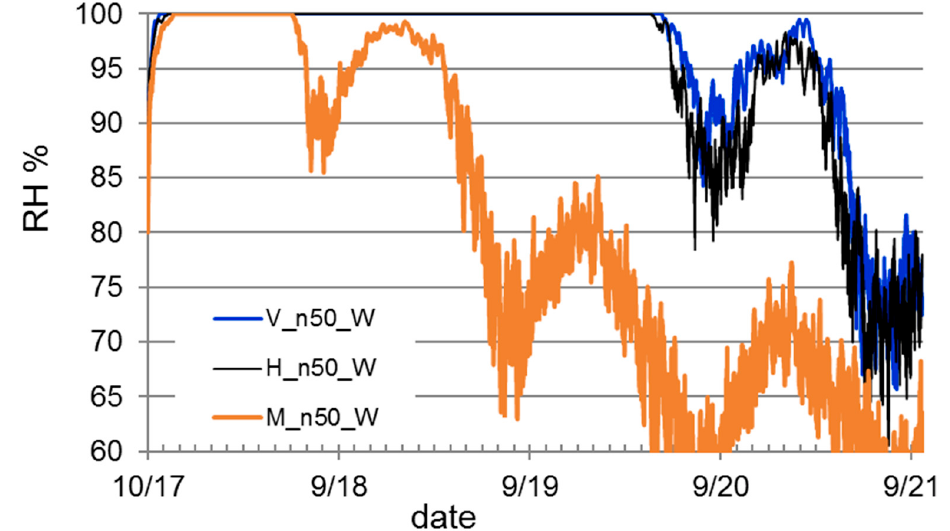
Figure 16. Brick wall, ventilation scheme 1, n = 50 1/h, initially wet exterior core of the old brick wall. The relative humidity in the boundary between mineral wool back layer insulation and the PU-insulation of the panel in three different climates during the four-year simulation period.